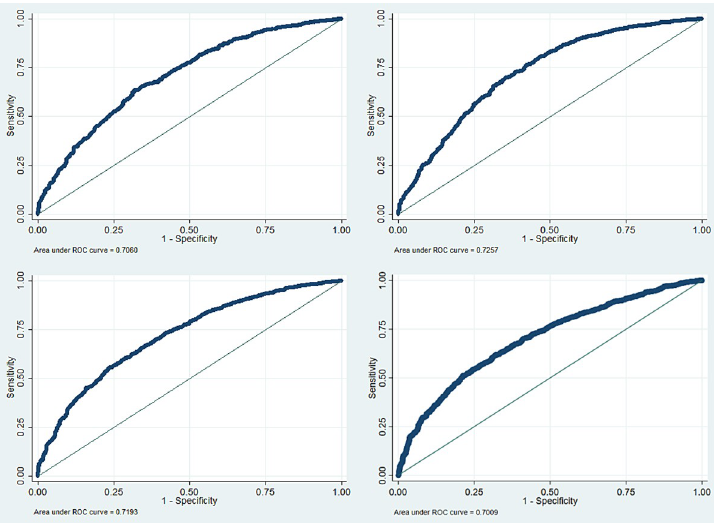
Fig 2. Receiver Operating Characteristic (ROC) analysis of the multivariate logistic regression models.